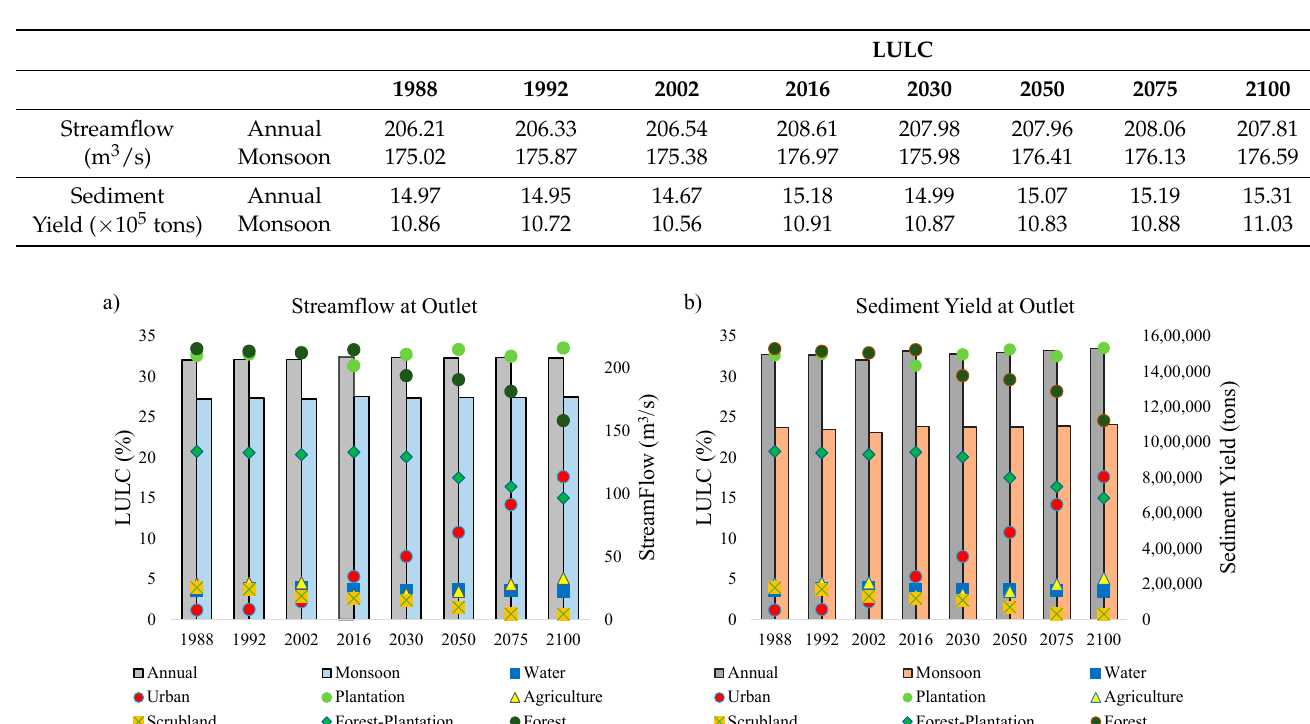
Table 3. Annual and monsoon SF and SY at the watershed outlet with varying LULC between 1988 and 2100.